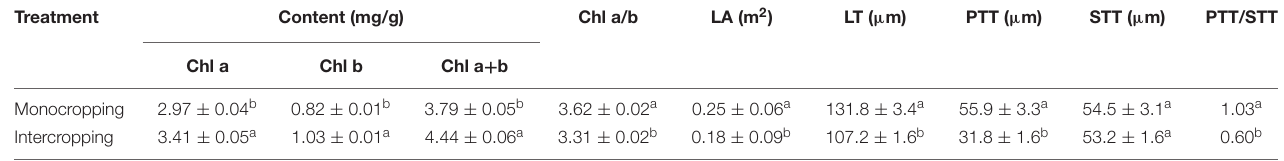
TABLE 1 | The content of chlorophylls, leaf area and morphological characteristic of soybean leaves under monocropping and intercropping. Treatment